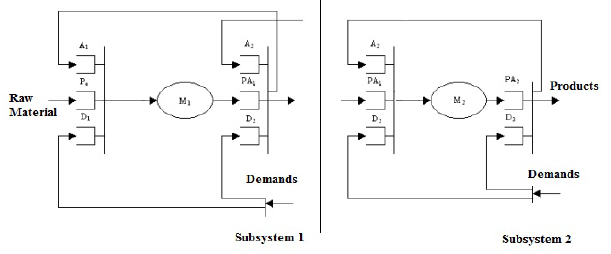
Figure 3. Decomposition of an Extended Kanban system Each subsystem in the above figure is connected to its